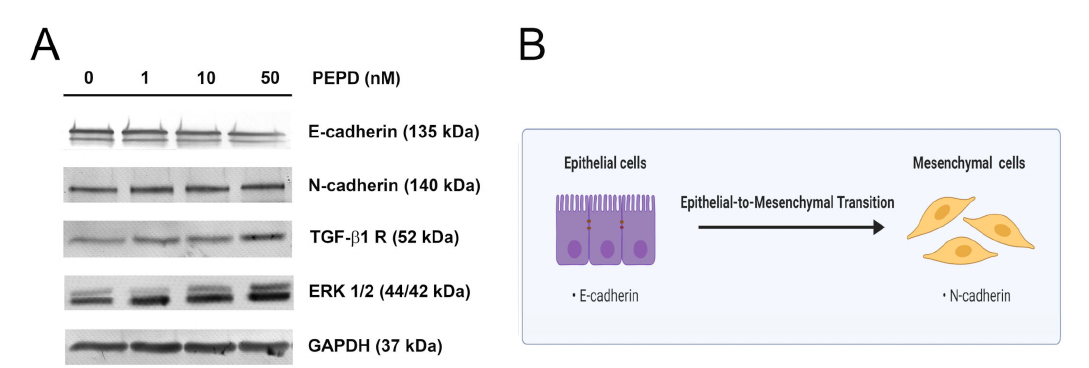
Figure 8. Extracellular prolidase a ff ects epithelial-to-mesenchymal transition in HaCaT cells. ( A ) The proteins of the EMT process were analyzed by Western immunoblotting in lysates of PEPD-stimulated HaCaT cells for 24 h. Representative blot images are shown (densitometric analysis of presented protein is included in Supplementary Materials (Supplementary Figure S9)). ( B ) An illustration of the idea for the epithelial-to-mesenchymal transition process. Created with